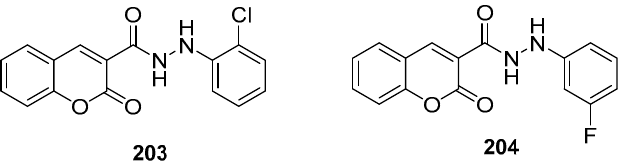
Figure 66. Chemical structure of compounds 203 and 204 .